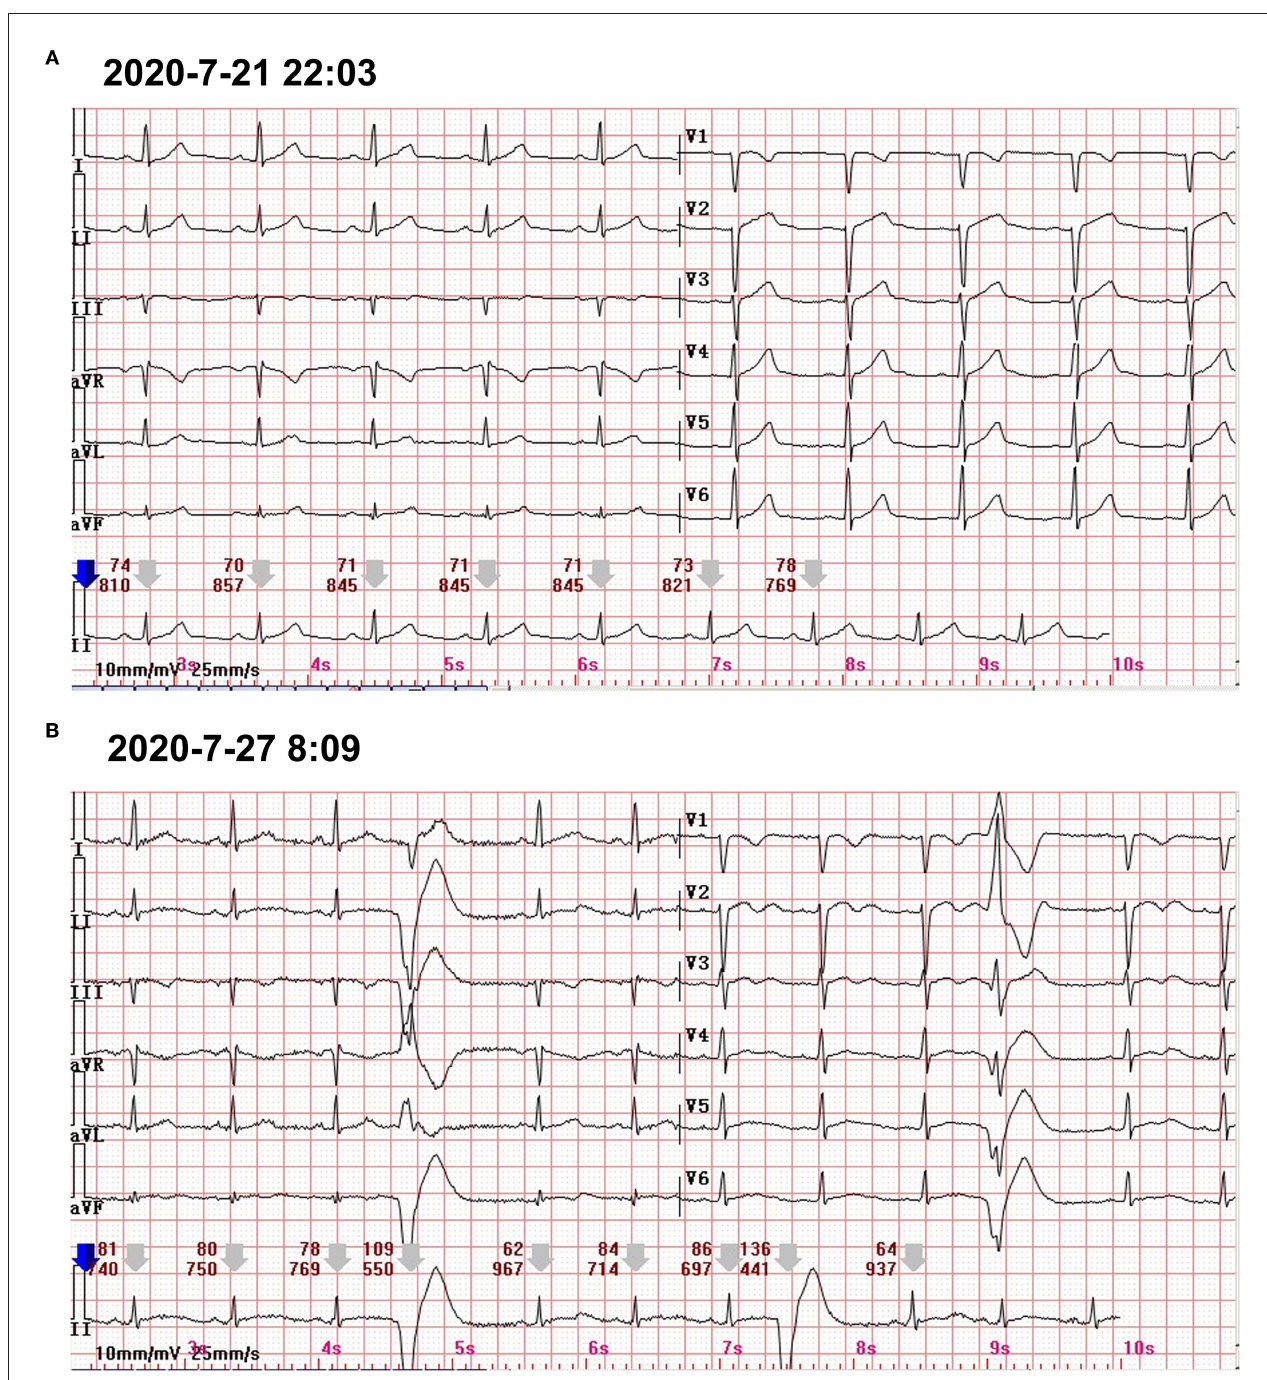
FIGURE 2 | (A) The 12-lead standard ECG only showed the poor progression of R waves in V1–V3. (B) A 24-h Holter ECG captured the occasional premature ventricular contractions.